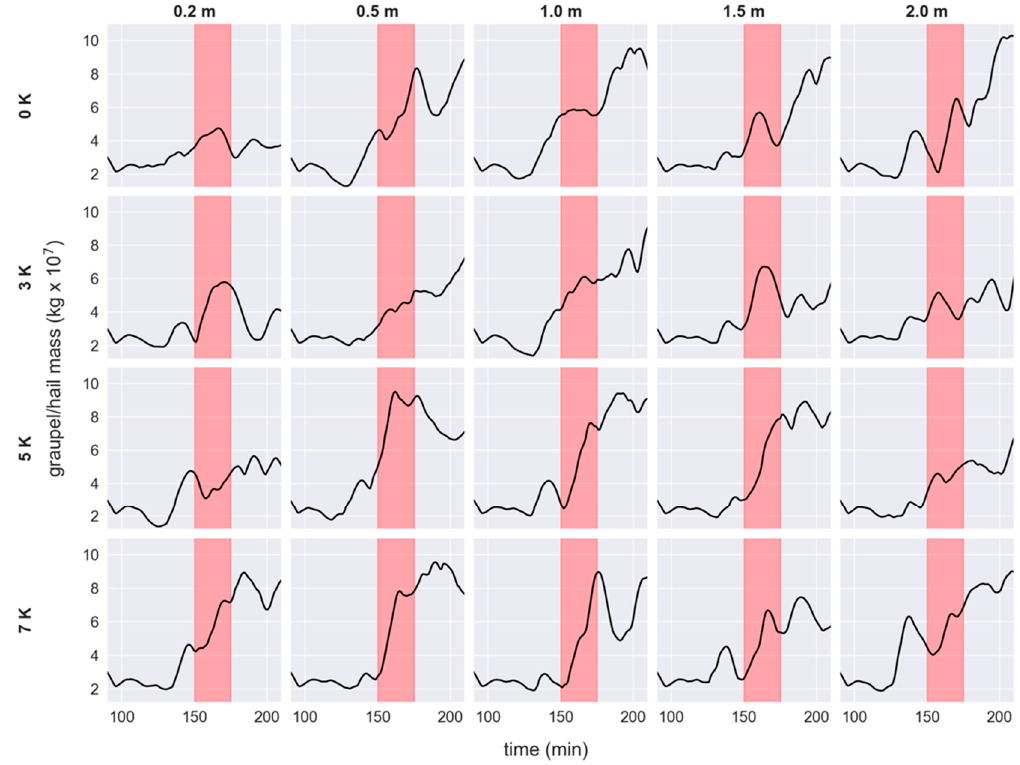
Figure 16. Time-series of domain total graupel/hail mass values. The red rectangle highlights the time period when the storm is passing over the idealized city.